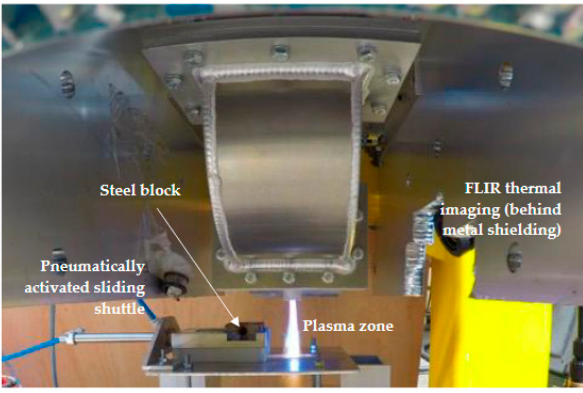
Figure 8. Laboratory temperature measurements using stainless steel block on mobile shuttle.